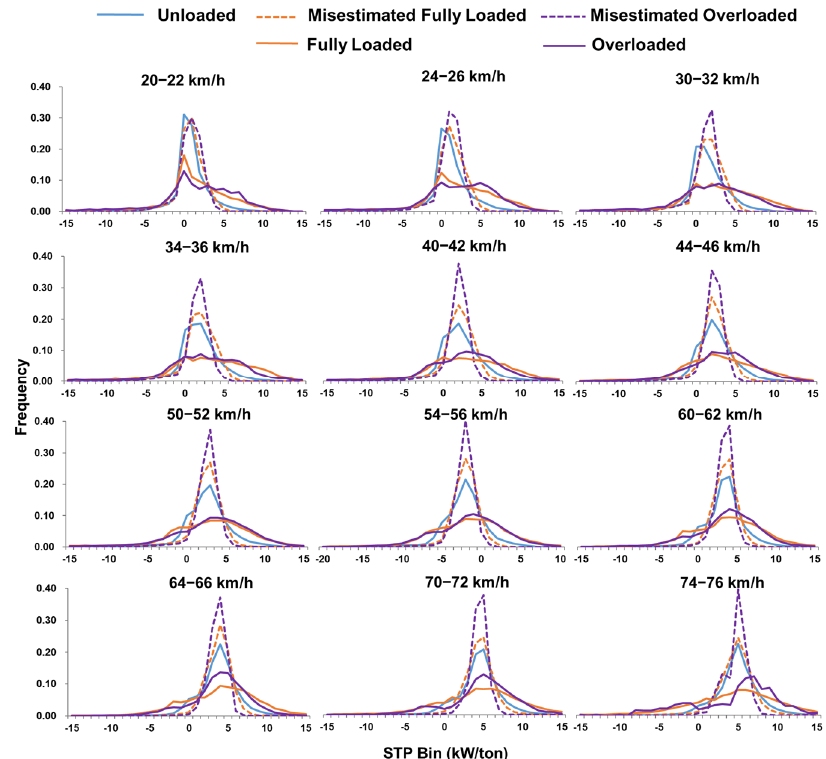
Figure 4. STP distribution for DSTTTs with unloaded, fully loaded and overloaded in different speed bins (unloaded, m = 14.5 tons; misestimated fully loaded, m = 14.5 tons; misestimated overloaded, m = 14.5 tons; fully loaded, m = 49.0 tons; overloaded, m = 61.5 tons).